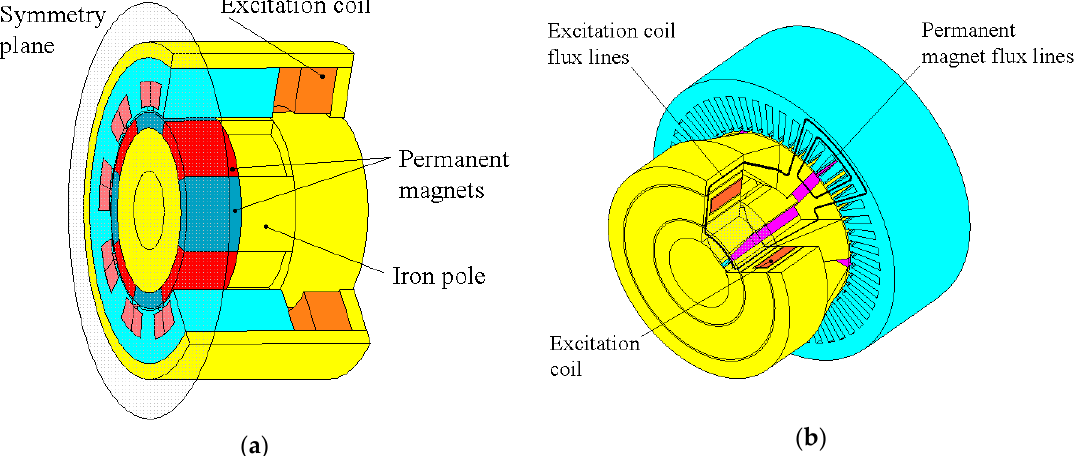
Figure 8. 3D parallel hybrid excited structures. ( a ) 3D juxtaposed structure [52]; ( b ) 3D imbricated structure [49,50].